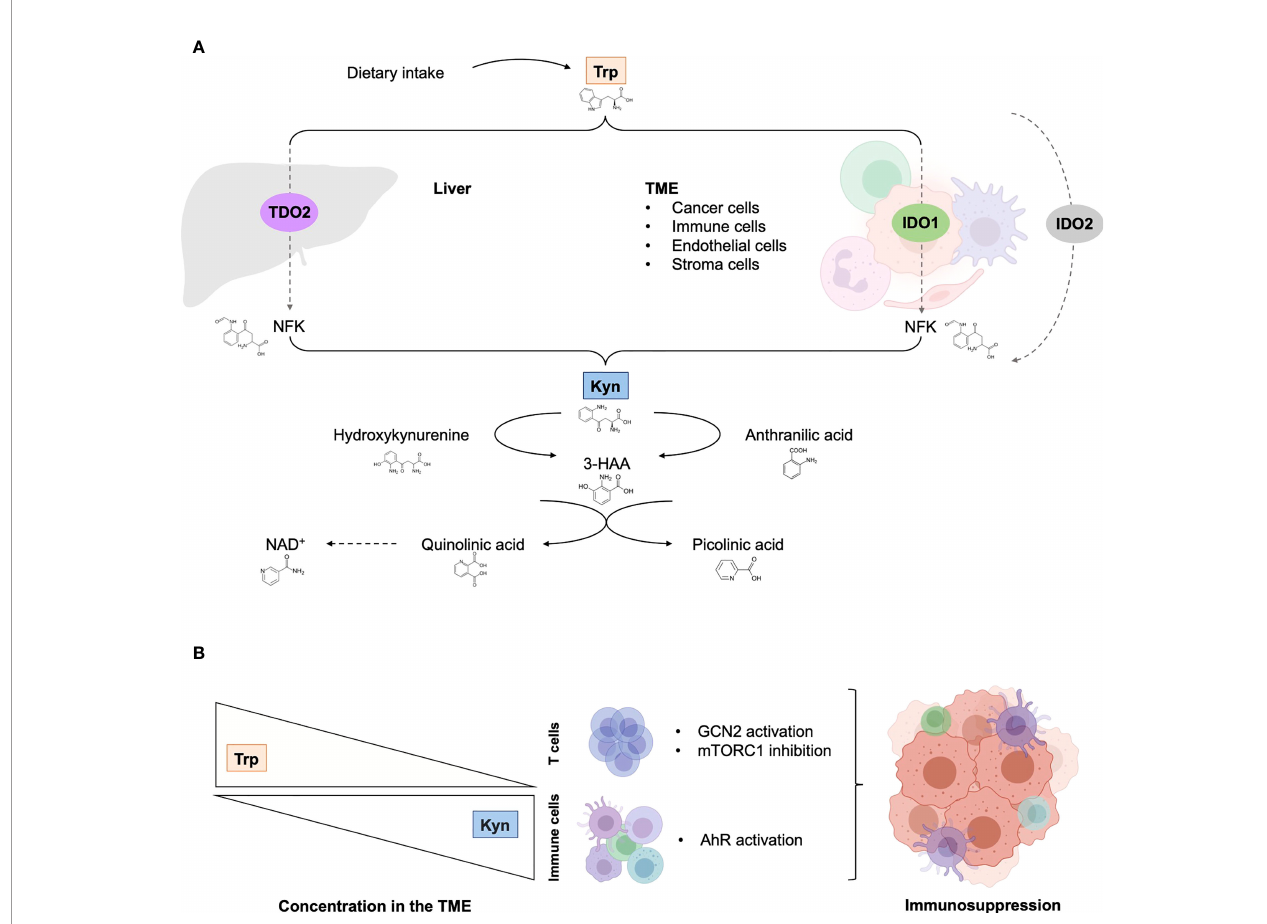
FIGURE 1 | The tryptophan catabolic pathway in cancer. (A) Provided by dietary intake, the essential amino acid Trp is catabolized into Kyn through three rate- limiting enzymes: TDO in the liver and IDO1/IDO2 in peripheral tissues. In tumor, IDO1 transforms Trp to Kyn by cleaving the 2,3-double bond of the indole ring, producing N-formyl kynurenine (NFK) that becomes rapidly and spontaneously converted into Kyn. The latter catabolite is further converted into downstream active intermediates, including hydroxykynurenine, anthranilic acid, 3-HAA, quinolinic acid and picolinic acid. The end-products of the pathway are NAD + and others molecules that fuel cellular metabolism. (B) Depletion of Trp in T cells suppresses activity in the mTORC1 signaling pathway and activates GCN2, inducing T cell dysfunction and leading to tumor-associated immunosuppression. Increase Kyn level in the TME leads to AhR in multiple tumor-associated immune cells, promoting immunosuppression functions. 3-HAA, 3-hydroxyanthranililic acid; AhR, aryl hydrocarbon receptor; GCN2, general control over nonderepressible 2; IDO1, indoleamine 2,3-dioxygenase (IDO1); Kyn, kynurenine; NAD + , nicotinamide adenine dinucleotide; mTORC1, mammalian target of rapamycin complex 1; NFK, N- formyl kynurenine; TDO, tryptophan 2,3-dioxygenase; TME, tumor microenvironment; Trp,